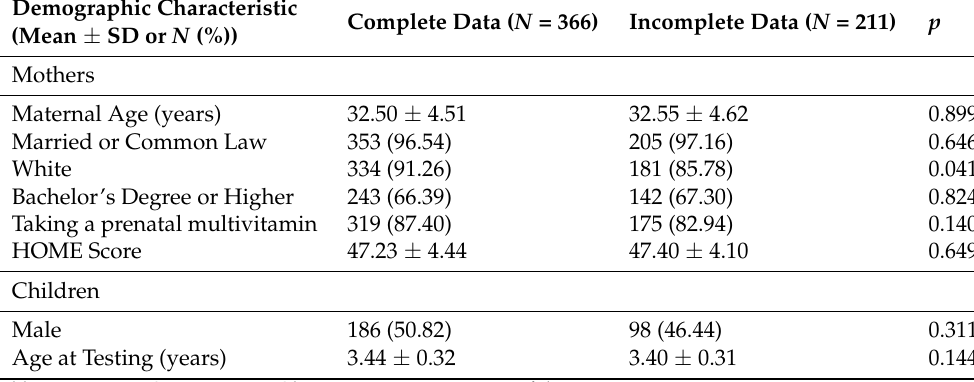
Table 1. Demographic Characteristics of those with Complete Data ( N = 366) and Incomplete Data ( N =